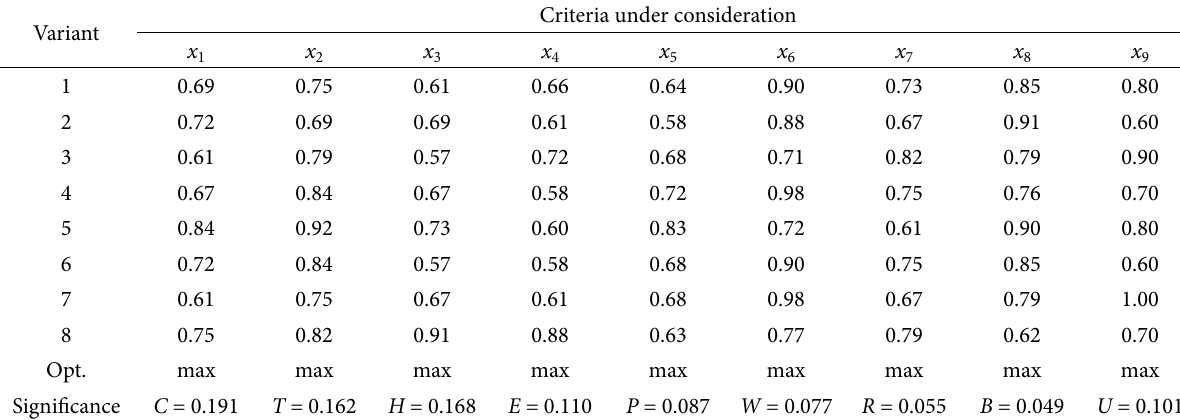
Table 2. Results of AMP quality assessment Variant